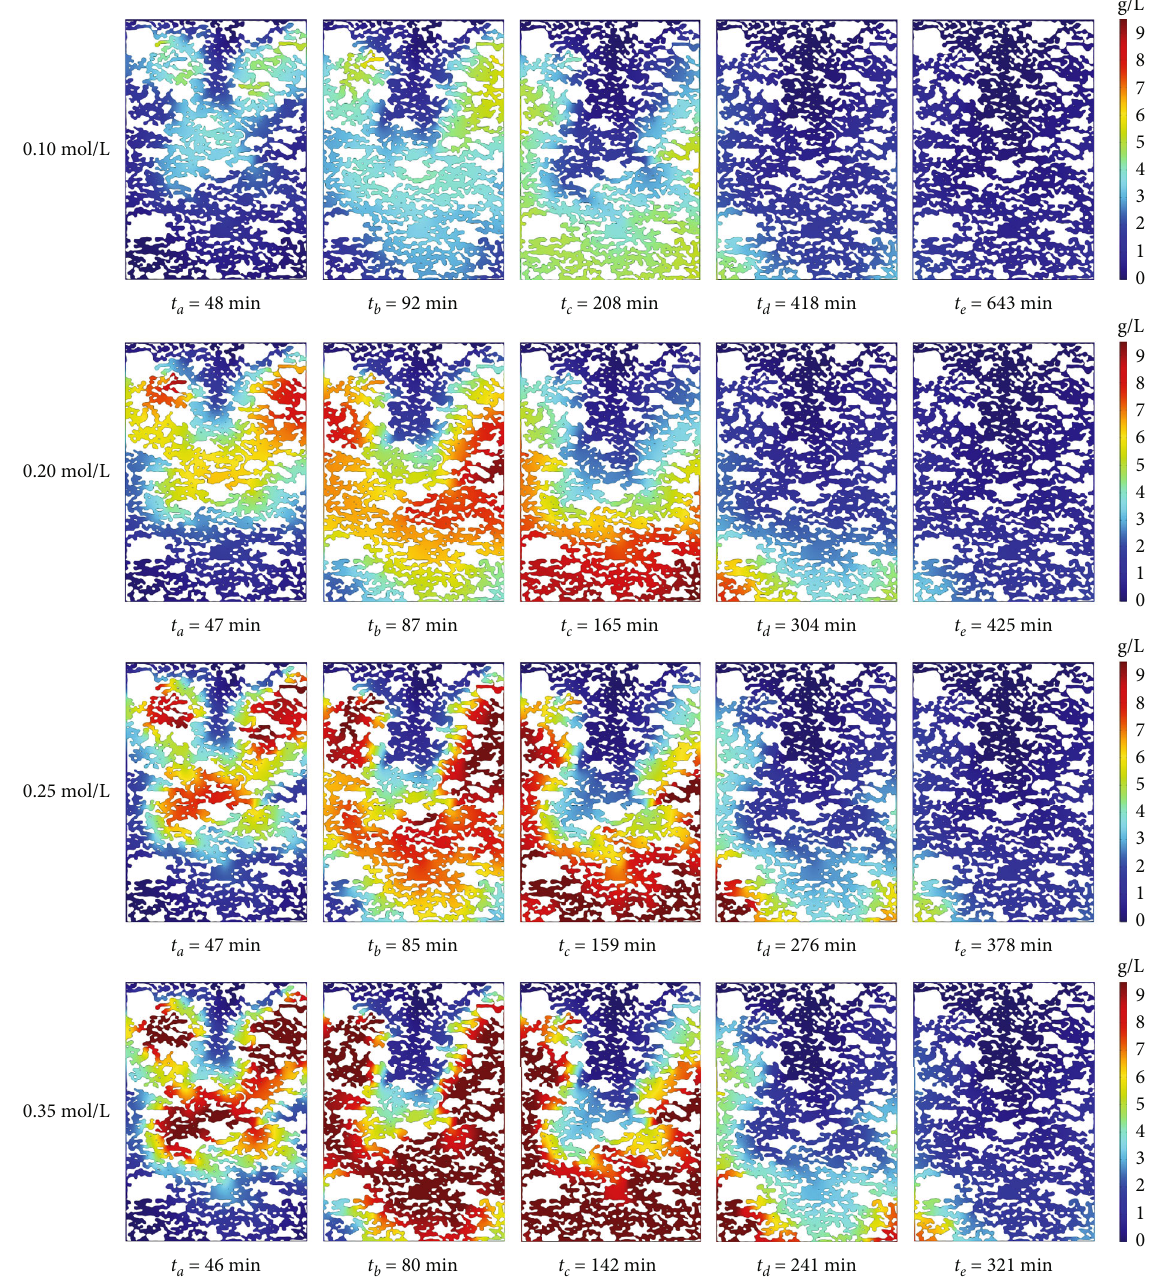
Figure 14: RE 3+ ion migration process under di ff erent leaching agent